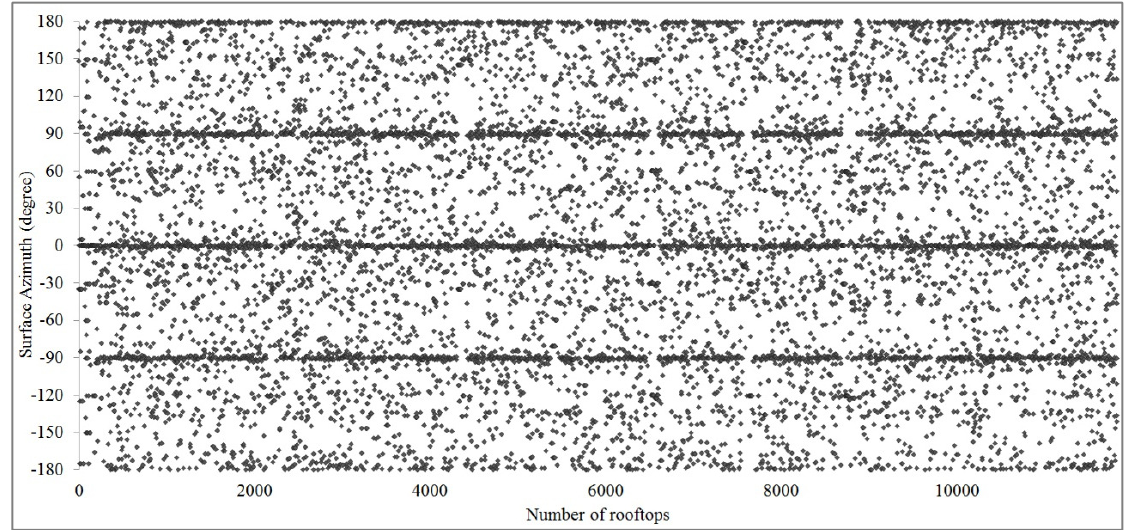
Figure 10. The distribution of surface azimuth of all rooftops from a LiDAR tile.